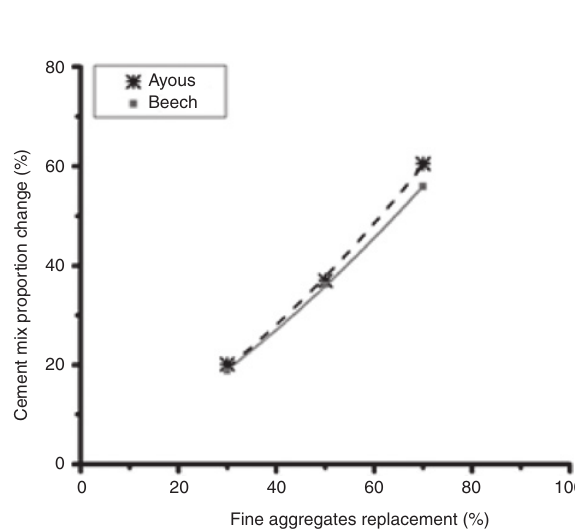
Figure 4: Percentage of cement mix proportion change (CMPC) versus the percentage of fine aggregates